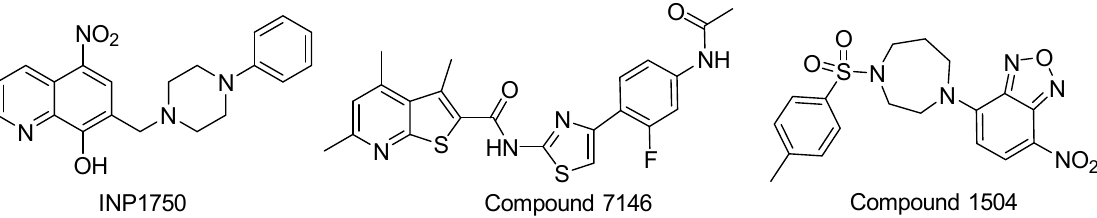
Figure 15. Structures of INP1750, compound 7146, and compound 1504.